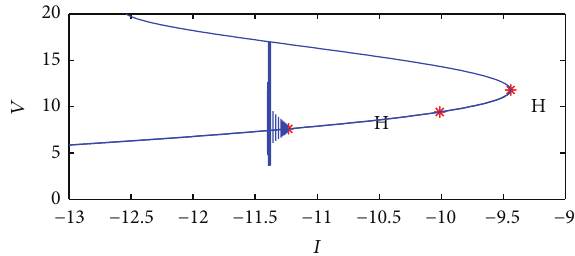
−13 −12.5 −12 −11.5 −11 −10.5 −10 Figure 5: The limit cycle emerging from sH at 𝐼 = −11.231605 .